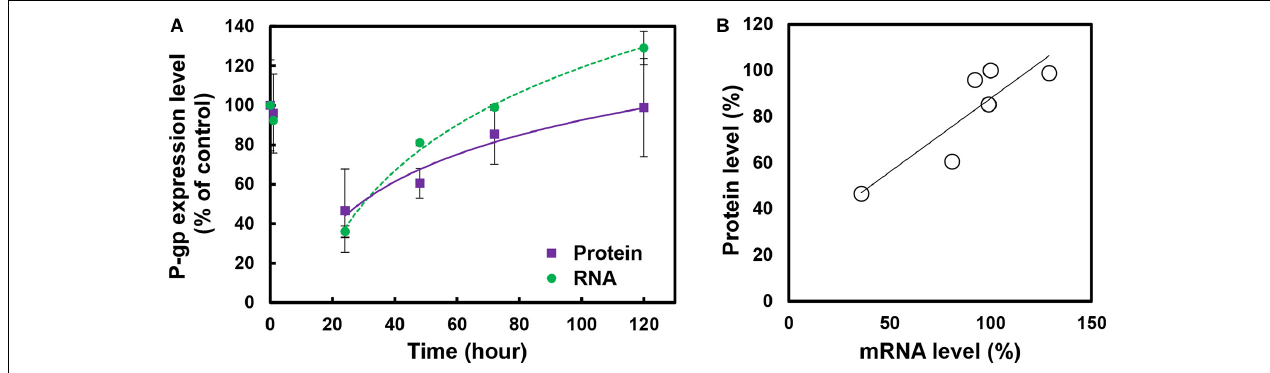
FIGURE 3 | Kinetics and correlation of P-gp expression in cerebral blood vessel after BBBD. (A) The curve plot showed changes between RNA and protein expression level at different times post-BBBD. (B) Scatter plot of P-gp protein expression level across its RNA expression. Correlation was assessed by Pearson’s correlation as positive linear regression ( r 2 = 0.76, P < 0.01).